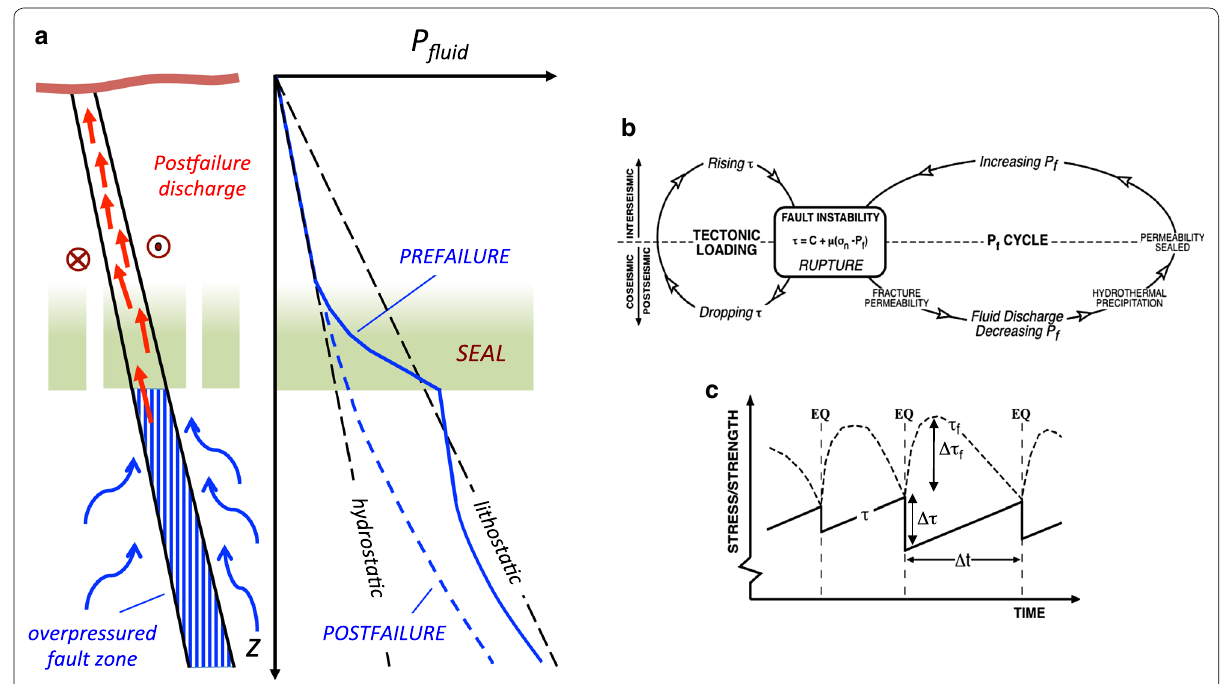
Fig. 4 a Schematics of fault-valve action after Sibson (2020); b shear stress, τ , and fluid-pressure, P f , cycles contributing to dual-drive failure; c relative amplitudes of shear stress and frictional strength cycles resulting from valving action ( b and c after Sibson